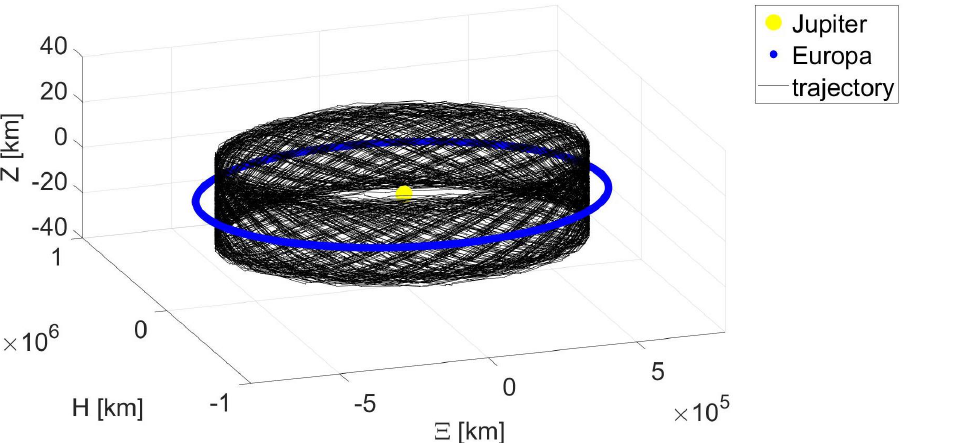
Figure 7. Representation of the vertical oscillator associated to a stationary point in the inertial